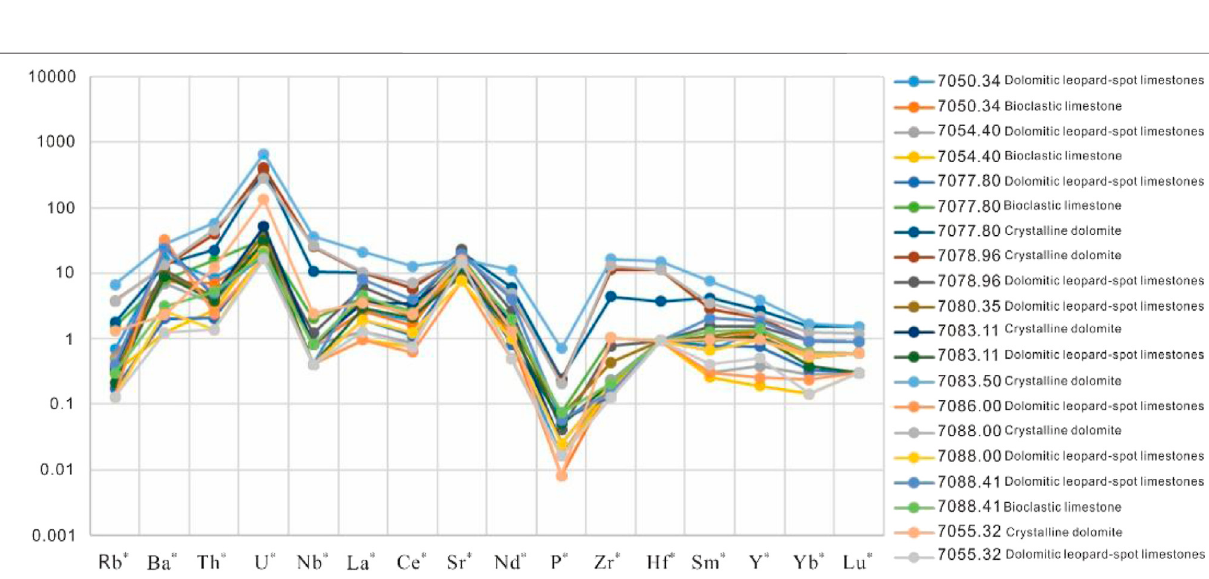
Frontiers in Earth Science |